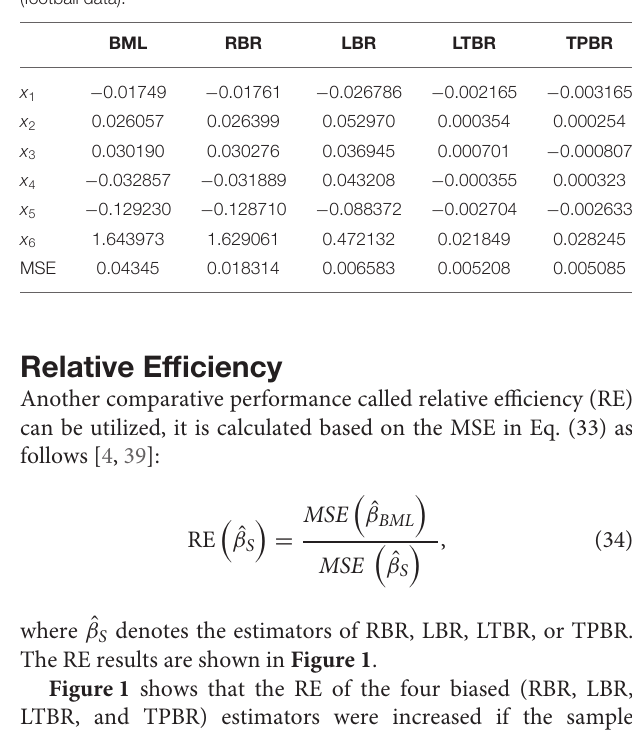
TABLE 6 | The estimated coefficients and MSE values for the used estimators (gasoline yield